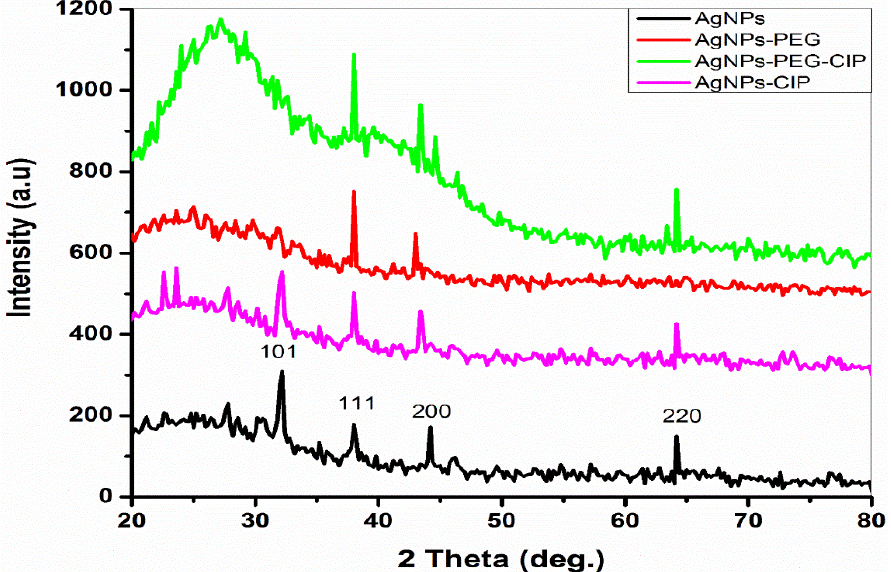
Figure 7. X-ray diffraction pattern of AgNPs and their conjugates.